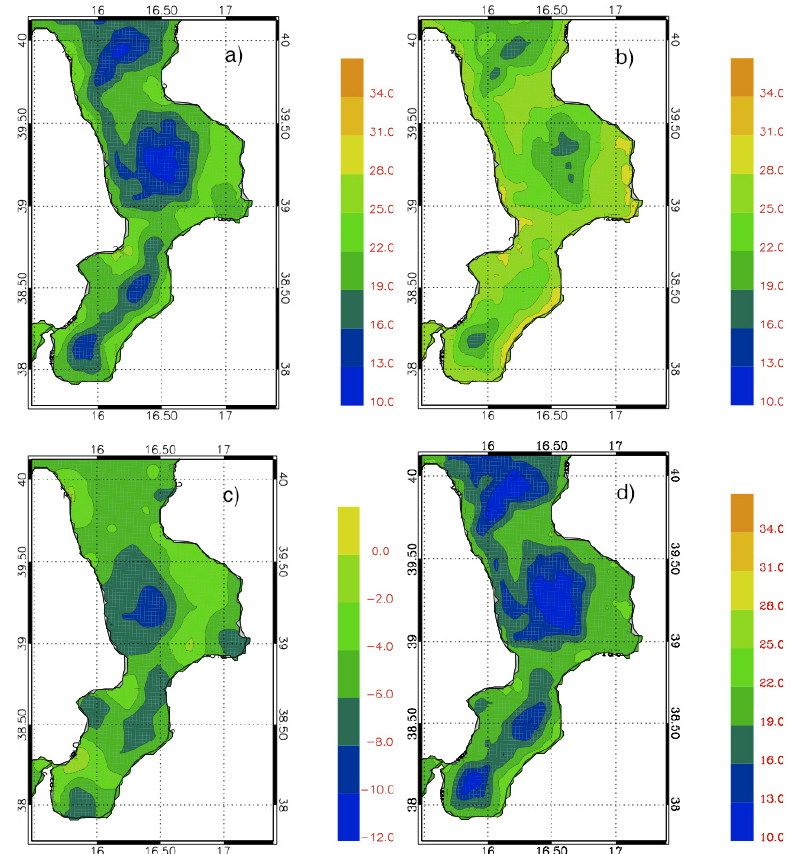
Fig. 7. As in Fig. 6, but for 15 September